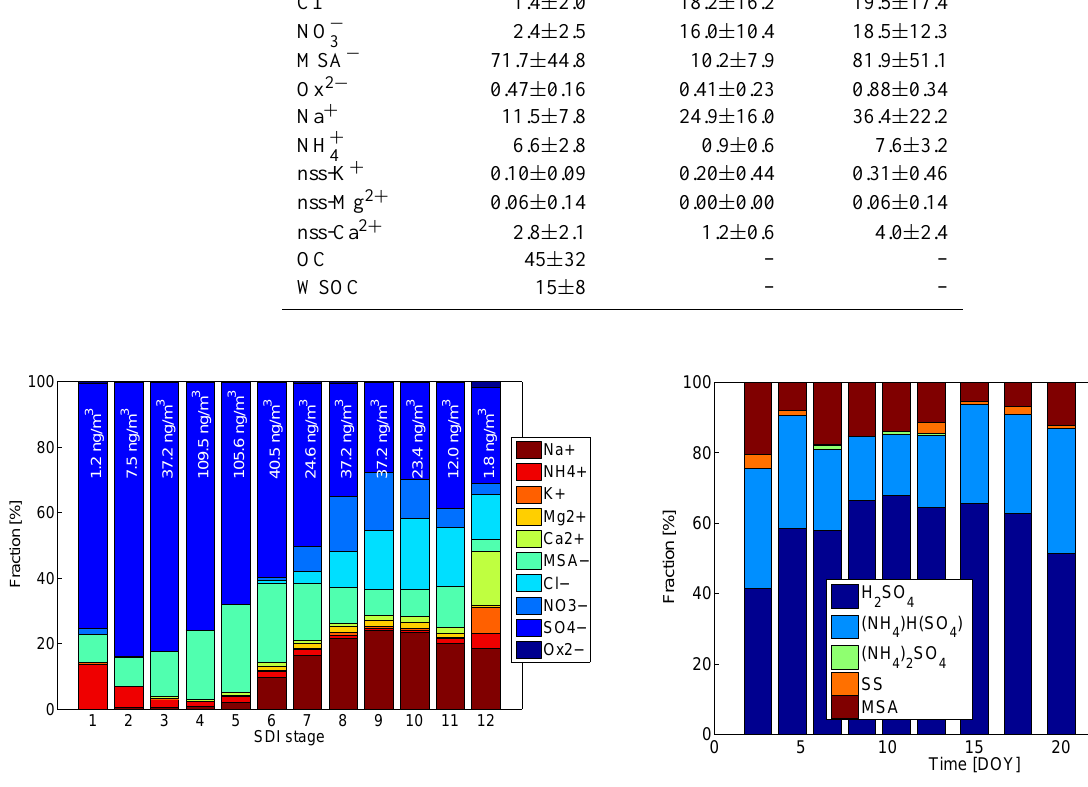
Fig. 11. Average relative masses of ten most abundant ions mea- sured with a 12-stage SDI impactor in January 2007 at Aboa. The Fig. 12. Relative mass composition of five components in aerosol SDI-stages 1–12 cover a aerodynamic size range from 45nm up to particles as a function of time measured in January 2007 at Aboa. 20µm. Each colour corresponds to an analysed ion which are: Na + , The fractions of massed are calculated using the summed masses NH + , K + , Mg 2 + , Ca 2 + , MSA − (CH 3 SO − ), Cl − , NO − , SO 2 − of the three lowest SDI-stages corresponding to a size range from 4 3 3 4 45nm up to 231nm. Each colour corresponds to a chemical com- and Oxalate − (C 2 O 2 − .) Additionally, the average sum of the ion 4 ponent which are: H 2 SO 4 , (NH 4 )HSO 4 , (NH 4 ) 2 SO 4 , Sea Salt (SS) mass concentrations at different stages are given in figure. and